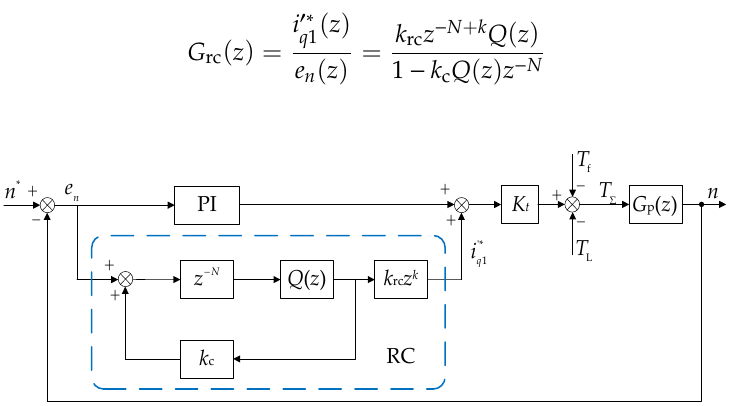
Figure 10. The block diagram of the control system with RC.